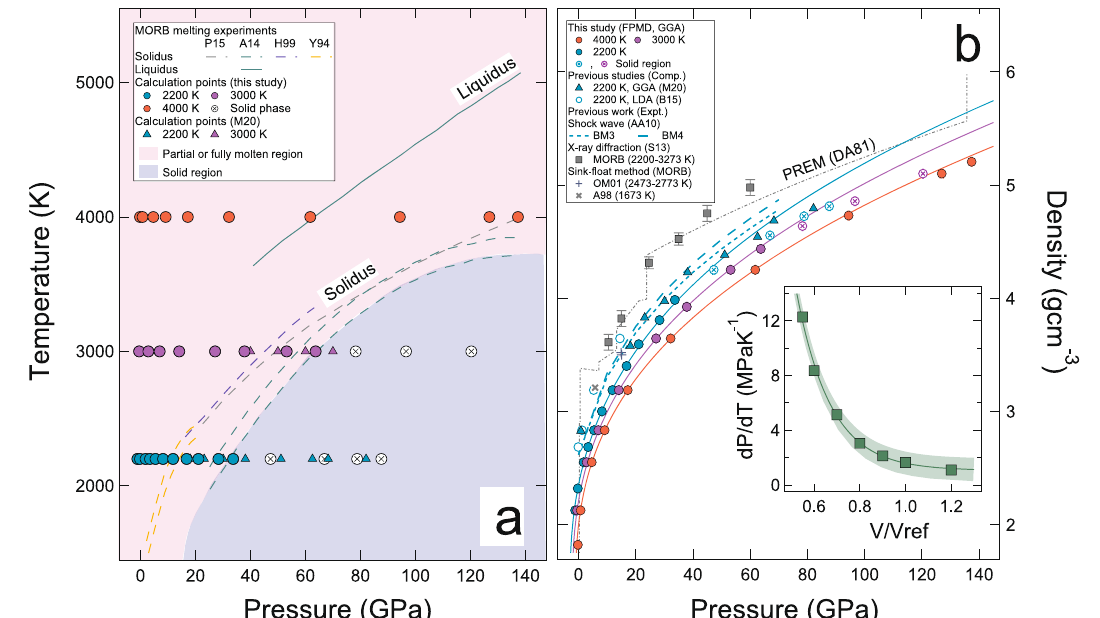
Fig. 1 | Melting temperature and equation of state. a Thermodynamic states of datapointsinthisstudyalongwiththemeltingcurveofbasalticmeltfromprevious work for reference. Light pink and light purple shaded regions in the fi gure represent the P – T space where melt and solid phases are stable, respectively. Dashed and solid lines represent MORB solidus 71,78 – 80 and liquidus 71 , respectively, from previous experiments. Filled circles show the temperature and pressure conditions of the simulation data points that are within the liquid or partial melt region of the phase diagram. Open circles with crosses are the data points that are in the solid regime of the phase diagram and thus not used in the analysis of the results. For comparison, the calculation points from the previous FPMD study at 3000K and 2200K are also shown by upward pointing triangles 46 . b Calculated pressure-density results ( fi lled circles) of the model basaltic melt at 4000K (red),